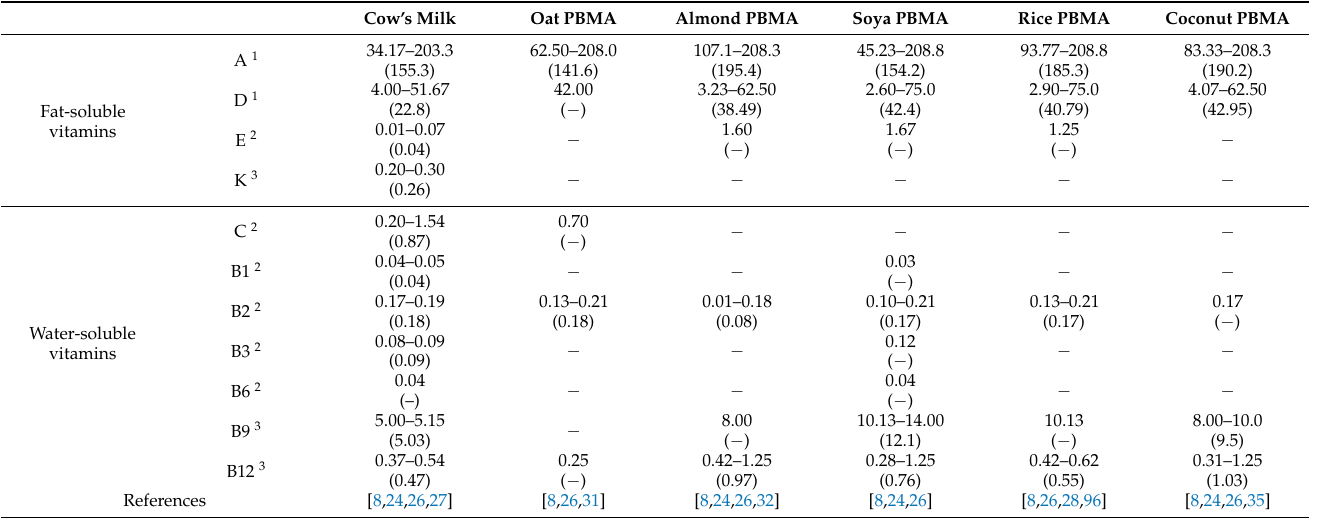
Table 6. Vitaminic composition (fat-soluble and water-soluble vitamins) of cow’s milk and some (oat, almond, soya, rice, and coconut) plant-based milk alternatives (PBMA). The data are presented by the range and the average in parenthesis. Cow’s Milk Oat PBMA Almond PBMA Soya PBMA Rice PBMA Coconut